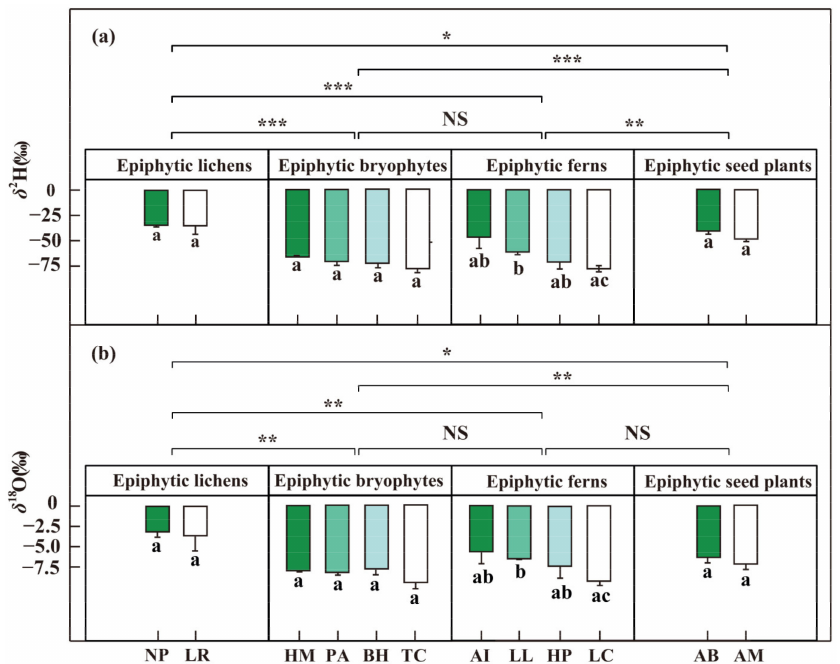
Figure 4. The δ 2 H ( a ) and δ 18 O (‰) ( b ) of epiphytes from different groups. Epiphytic lichens ( n = 4): NP, Nephromopsis pallescens ; LR, Lobaria retigera . Epiphytic bryophytes ( n = 4): HM, Hamaliodendron montagneanum ; PA, Plagiochila assamica ; BH, Bazzania himlayana ; TC, Thuidium cymbifolium . Epiphytic ferns ( n = 4): AI, Asplenium indicum ; LL, Lepisorus loriformis ; HP, Hymenophyllum polyanthos ; LC, Loxogramme chinensis . Epiphytic seed plants ( n = 4): AB, Aeschynanthus buxifolius ; AM, Agapetes mannii .) in the dry season, January 2019. Wilcoxon rank sum test is used to verify the differences of epiphyte samples (NS > 0.05, * p < 0.05, ** p < 0.01, *** p < 0.001); Error bars represent mean ±